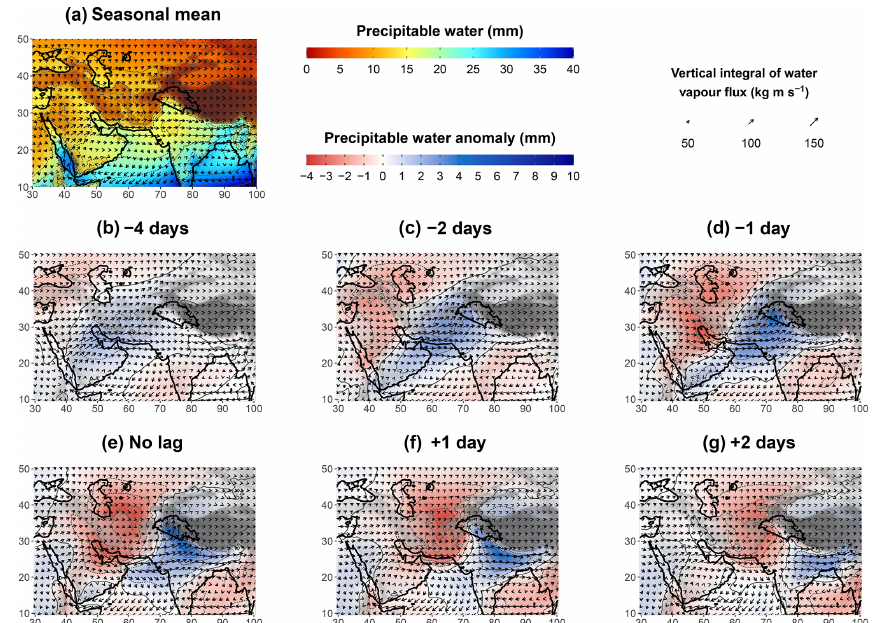
Figure 10. (a) The seasonal mean of precipitable water (colour shading, thin contour lines every 5mm) and vertical integral of water vapour flux (arrows). The mean is weighted by the seasonality of the occurrence of UV700 above its 90th percentile. Panels (b) to (g) show the lead–lag composite maps, with respect to the 10% highest values of UV700 (as in Fig. 3), of the precipitable water anomaly (colour shading, thin contour lines every 2mm) and absolute water vapour flux (arrows). Non-significant anomalies at the 95% level are shown in